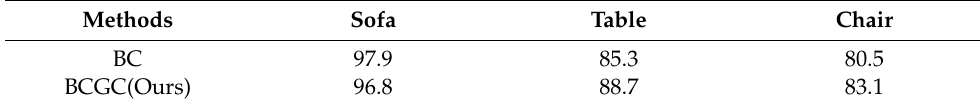
Table 1. Average Jaccard scores for different methods.